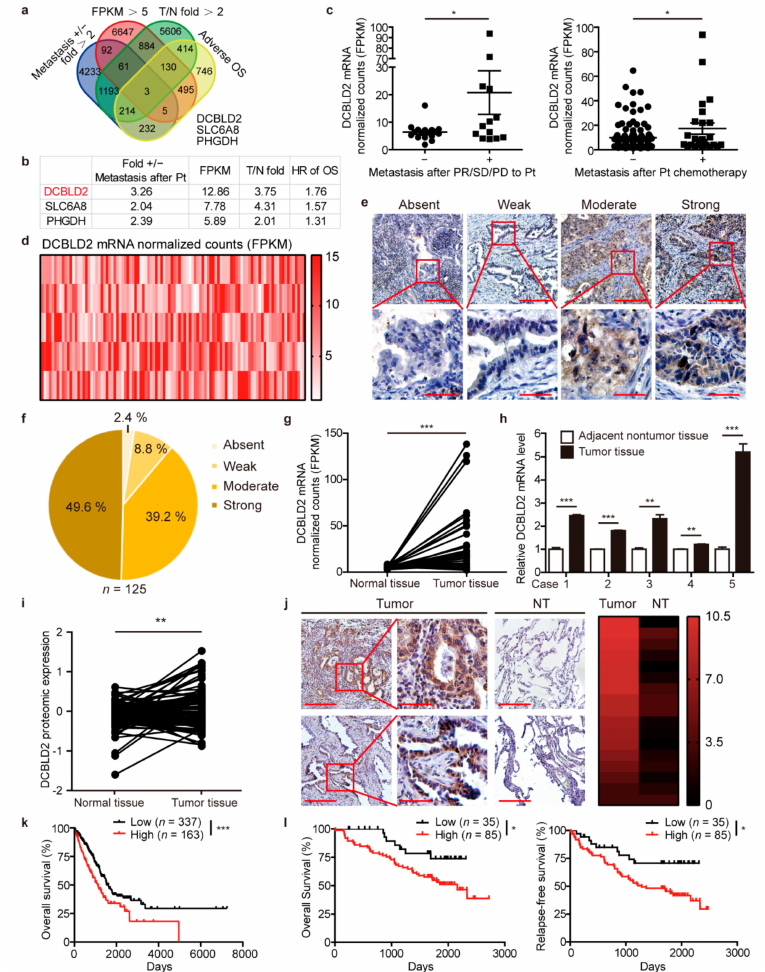
Figure 2. DCBLD2 is a candidate gene involved in cisplatin-induced metastasis. ( a ) Screening strategy for key genes related to distant metastasis after platinum-based chemotherapy. ( b ) Ranking of the 3 identified candidate genes according to the 4 criteria. ( c ) Differential expression of DCBLD2 at the transcriptional level in LUAD patients from the TCGA database with or without distant metastasis when responding to platinum agents with a partial response, stable disease, or progressive disease (left). DCBLD2 expression in LUAD patients with distant metastasis who received platinum agents (right). * p < 0.05, t -test. ( d ) The heat map of DCBLD2 expression in mRNA normalized count (log 2) in LUAD tissues from the TCGA database ( n = 515). ( e , f ) Representative images ( e ) and distribution ( f ) of DCBLD2 expression in LUAD tissues by IHC assay ( n = 125). Scale bar: 200 µ m (top), 50 µ m (bottom). ( g ) Transcriptional analysis of the differential expression of DCBLD2 in paired LUAD tissues and normal tissues from the TCGA database ( n = 57), p = 0.0003, paired t -test. ( h ) DCBLD2 expression at the mRNA level in LUAD tissues and adjacent nontumor tissues by RT-PCR ( n = 5). ** p < 0.01, *** p < 0.001, t -test. ( i ) Differential expression of DCBLD2 at the protein level in LUAD tissues and paired normal tissues from the CPTAC database ( n = 102), ** p < 0.01, paired t -test. ( j ) Representative images of DCBLD2 expression in LUAD tissues and paired nontumor tissues ( n = 17) by IHC assay. Scale bar: 200 µ m (left), 50 µ m (middle), 200 µ m (right). Wilcoxon’s rank tests, Z = − 3.524, p < 0.001. ( k ) Kaplan-Meier analysis of OS of 500 LUAD patients from the TCGA database stratified by DCBLD2 levels. The cutoff for DCBLD2 expression was 9.5 FPKM. Log-rank tests, p = 0.0002. ( l ) Kaplan-Meier analysis of OS and RFS of 120 LUAD patients according to different DCBLD2 levels. The cutoff line for H score was 5. Log-rank tests, p = 0.0418 and p = 0.0140,